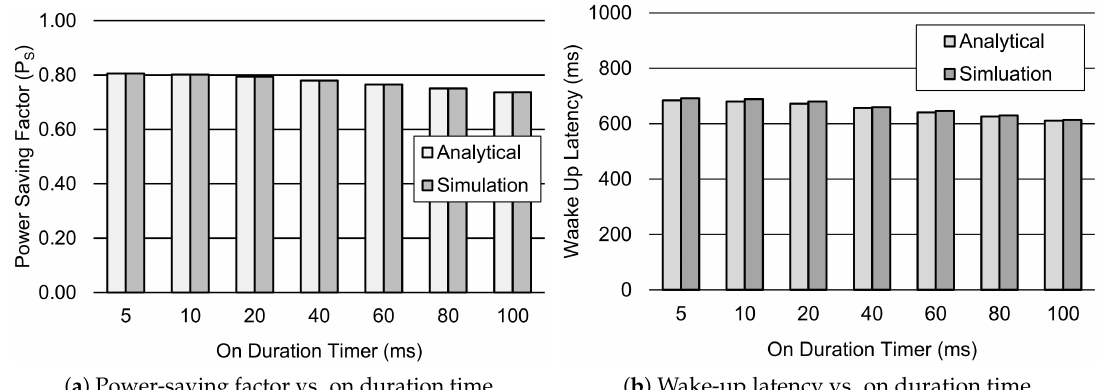
Figure 6. Performance analysis of the DRX mechanism for different values of T ON . Other parameter settings include 1